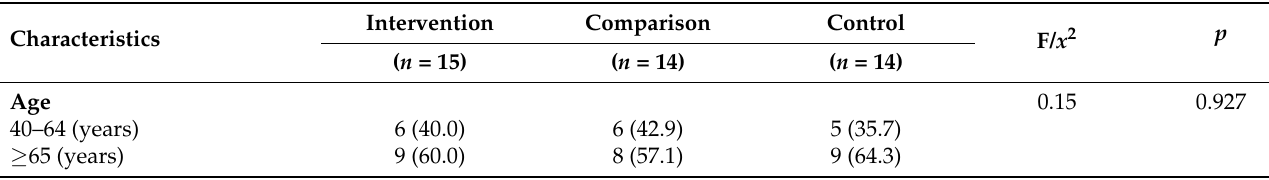
Table 2. Comparison of baseline characteristics including demographics, number of chronic diseases, self-perceived health status, physical activity amount, and health-related physical fitness. Characteristics